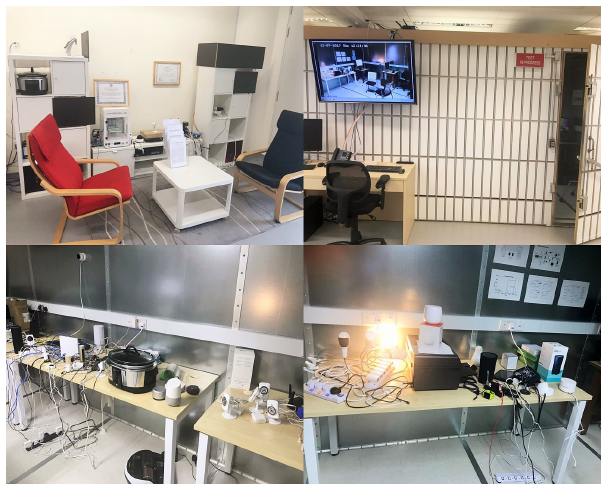
Figure 1. Smart Home Setup and IoT Security Testbed and the maximum number of packets arising in and out of the IoT device is calculated. (2) The Control and Communication Machine runs Algorithm 2 , which is dedicated to various attacks. (3) The Analysis Machine runs Algorithm 3 of our framework, which is dedicated to the defense